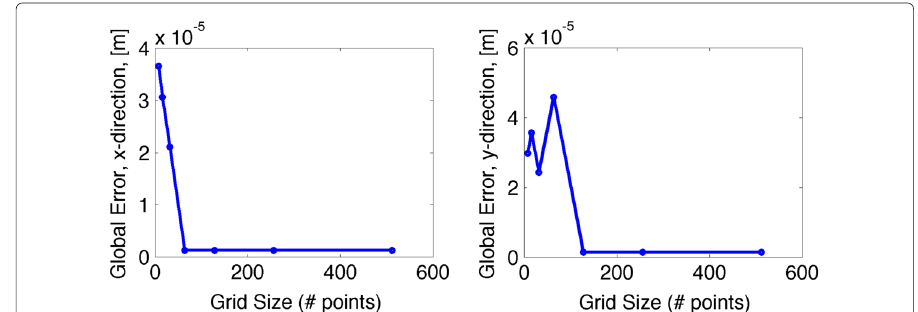
Fig. 5 Global error for various grid sizes in the x-direction ( left ) and y-direction ( right ). The error is shown to converge to a minimum with a grid size of 128